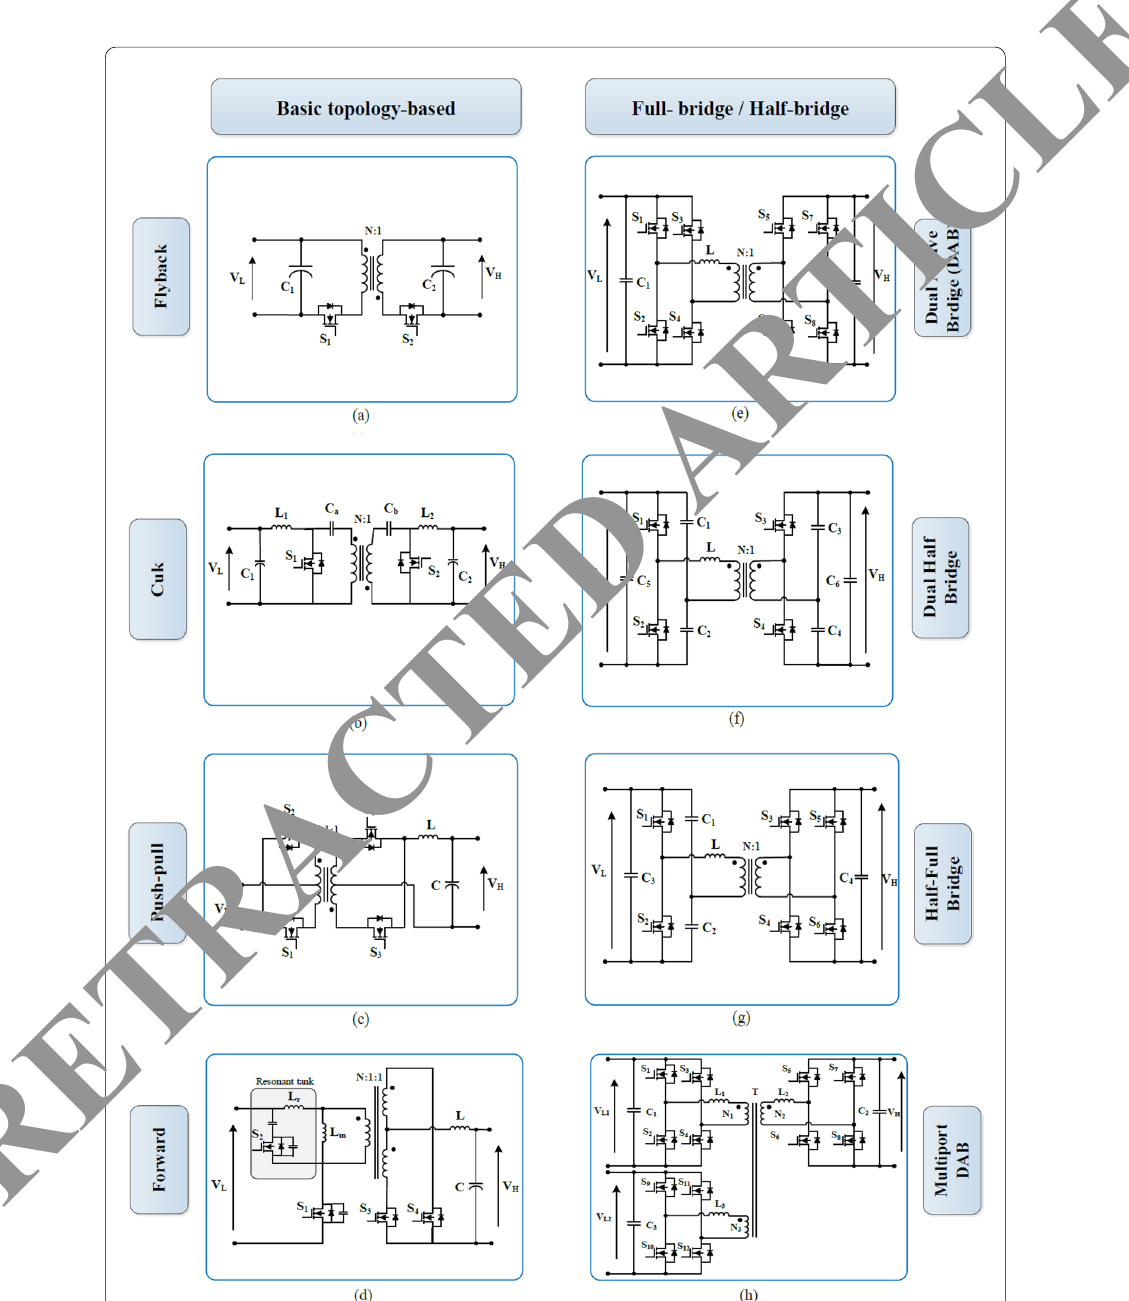
Fig. 8 Isolated bidirectional DC-DC converter topology classification. ( a ) Application of smart control in power electronics, ( b ) usage of metaheuristic methods in power electronics, and ( c ) usage of machine learning methods in power